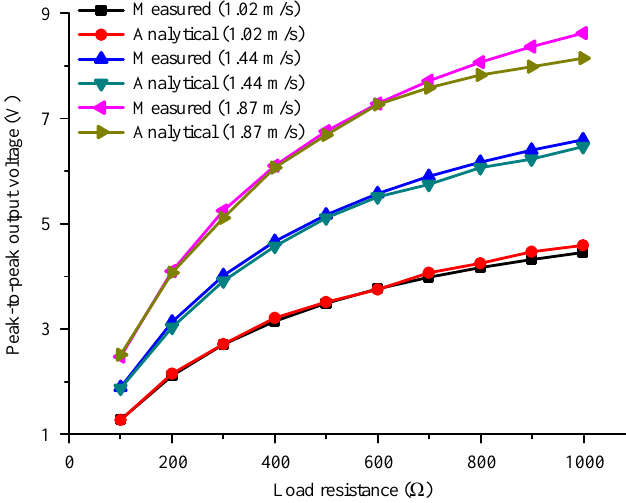
Figure 12. Experimental and analytical results of output voltage varying with load resistance.